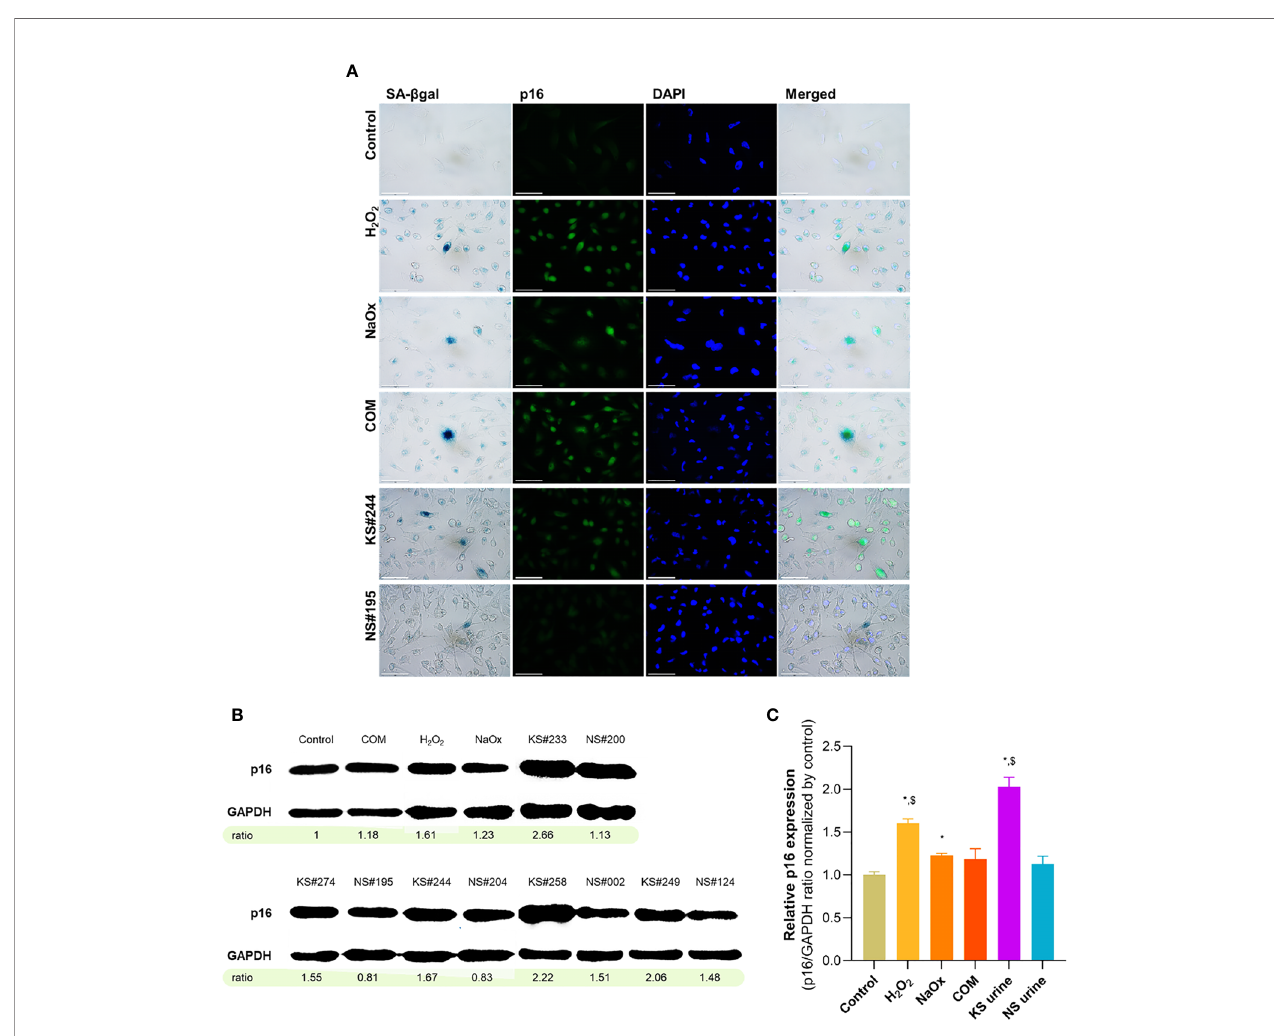
FIGURE 3 | Upregulation of p16 in senescent HK-2 cells induced by their treatment with sodium oxalate (NaOx), calcium oxalate monohydrate (COM), and urine from patients with KS (KS urine). (A) Dual staining from SA- b gal and p16 immuno fl uorescence. p16 immunoreactivity is intensely positive in SA- b gal positive cells. (B) Western blot showing increased p16 expression in HK-2 treated with H 2 O 2 , oxalate, and urine from patients with KS. Numbers indicates intensity ratios of p16-to-GAPDH normalized by untreated control. (C) Relative p16 expression, indicated by intensity ratios of p16-to-GAPDH, compared between conditions. KS urine induced p16 expression signi fi cantly higher than NS urine and in untreated control cells. Error bars indicate SEM. Scale bar indicates 50 µm. * P < 0.05 vs. Control, $ P < 0.05 vs. NS